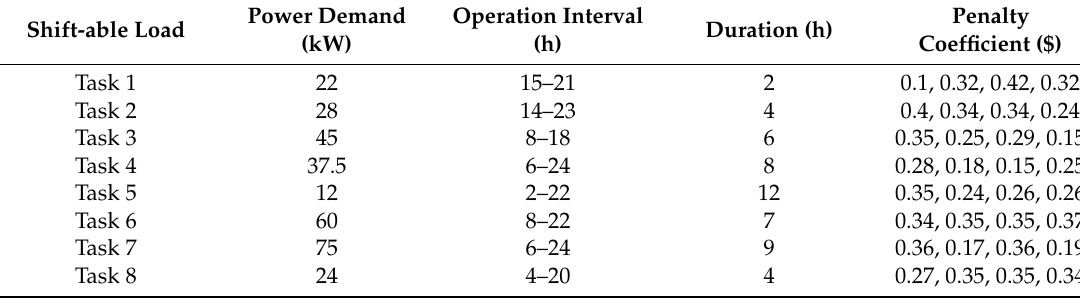
Table 3. Parameter of shift-able